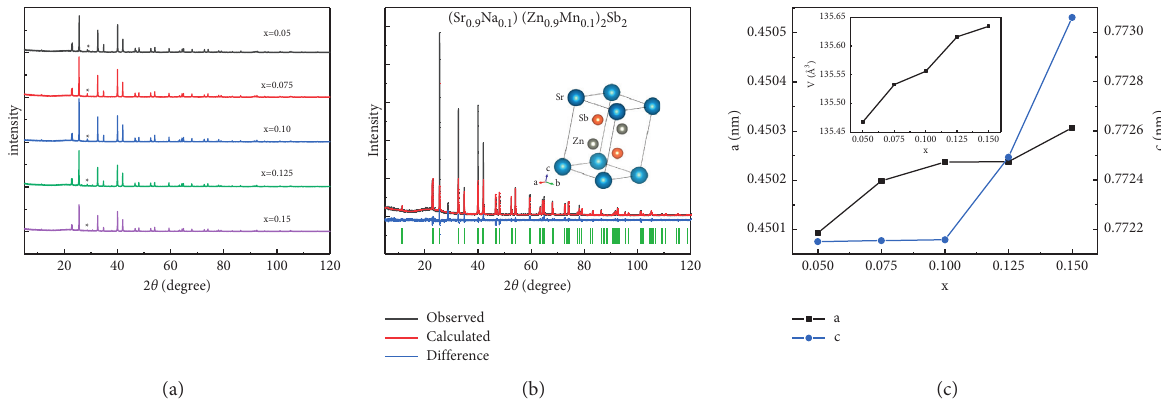
Figure 1: (a) The X-ray diffraction patterns for ( Sr ZnSb( ∗ ) are marked. (b) The rietveld refinement of ( Sr parameters a and c for ( Sr